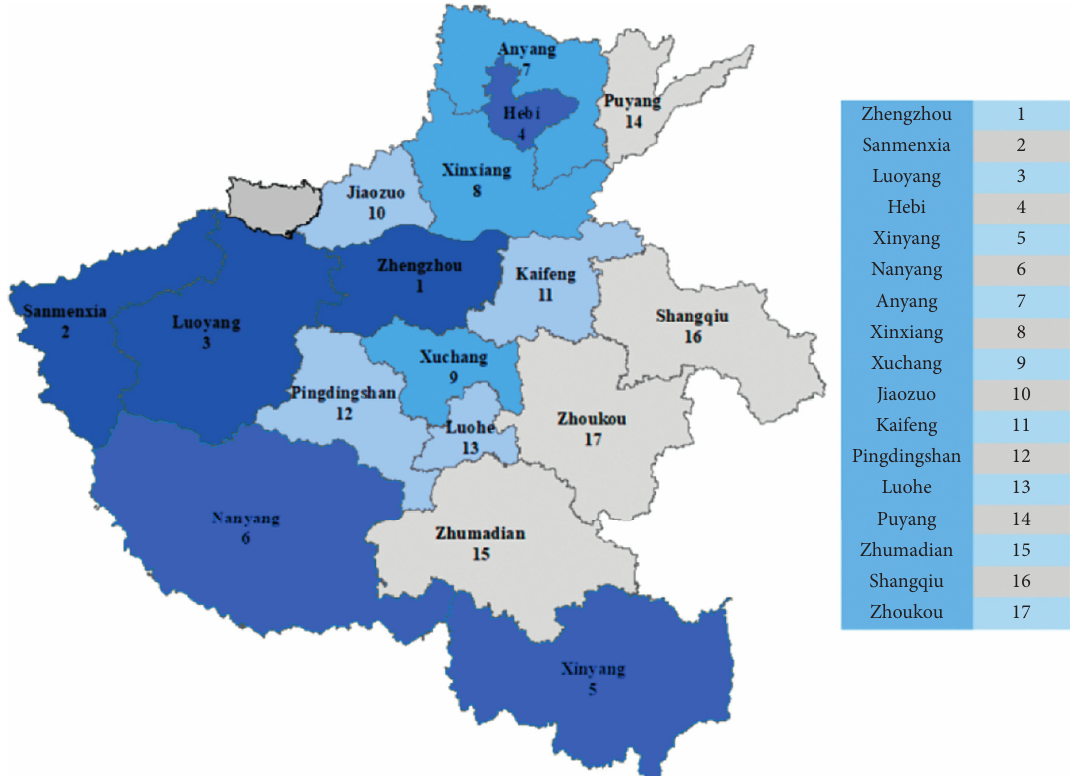
Figure 7: The comprehensive ranking of the sustainable development of cities in Henan Province in the social dimension.